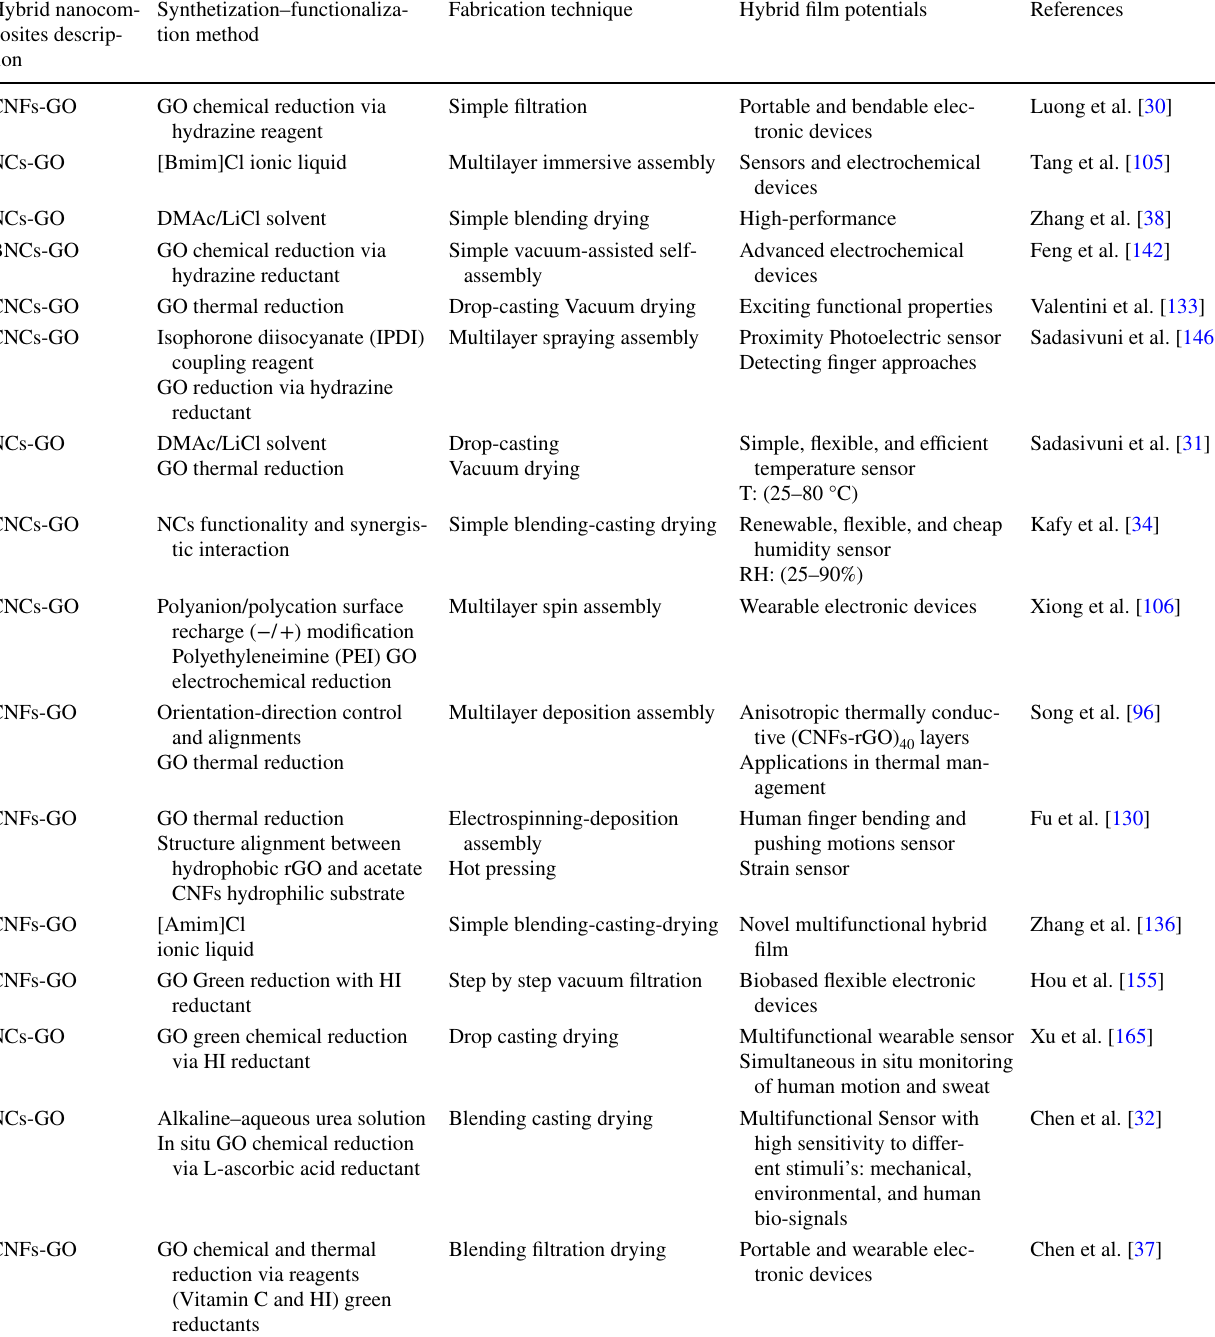
Table 1 Tabulation of the synthetization, functionalization, fabrication, and properties for a variety of hybrid NCs-GO/rGO nanocomposite films Hybrid nanocom- posites descrip-